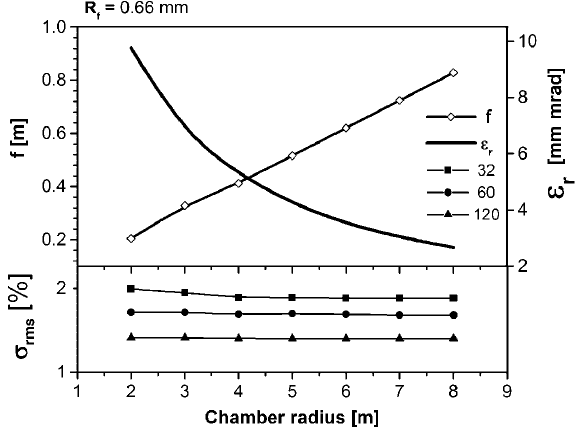
FIG. 11. The relationship between the beam transverse emit- tance, focal distance, and the rms nonuniformity. The beam emittance should decrease and the focal distance f should increase with the increase in the chamber radius R